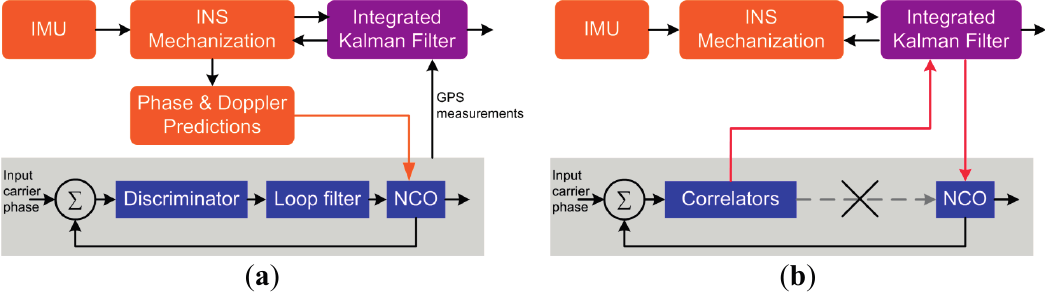
Figure 1. Two architectures of GPS/INS deeply coupled integration. ( a ) Scalar-based architechture; ( b ) Vector-based